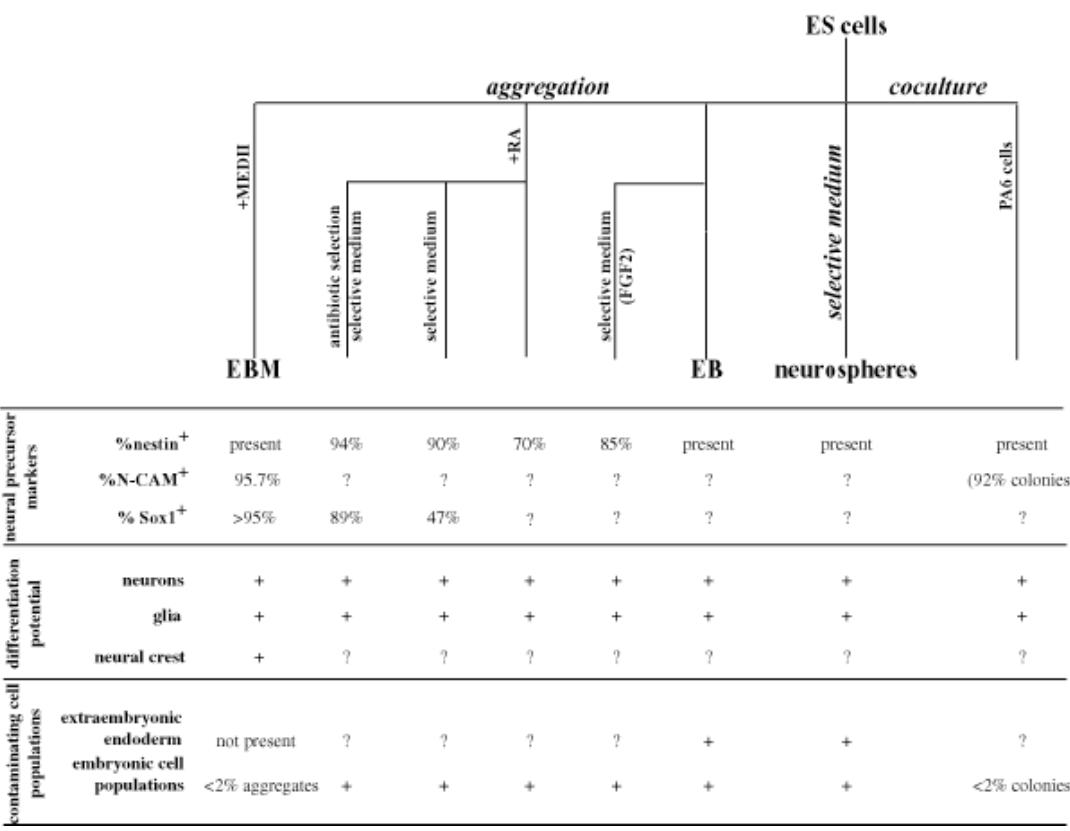
FIGURE 1. Summary of the approaches and outcomes of differentiation of ES cells to neural lineages. The data presented were compiled from[24,31,45,48,50]. Where the data have not been determined, no values have been entered in the